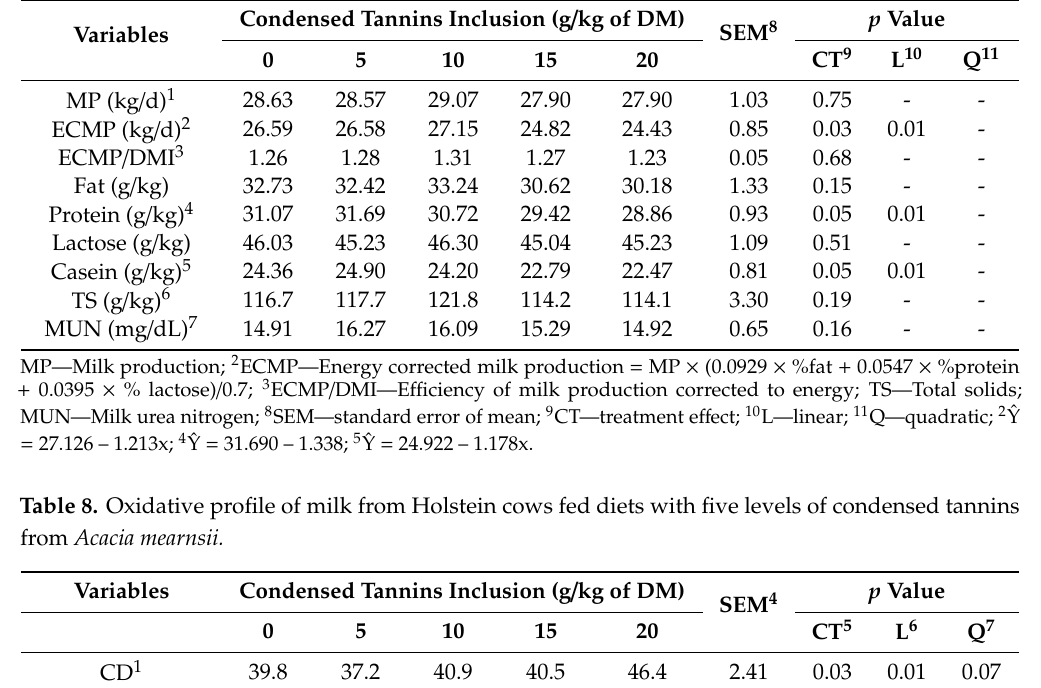
Table 7. Milk production and composition from Holstein cows fed diets with five levels of condensed tannins from Acacia mearnsii.